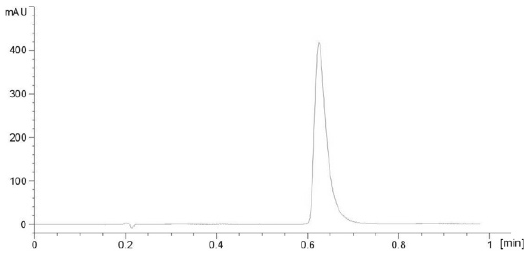
Figure 2. Representative chromatogram of famotidine from dissolution